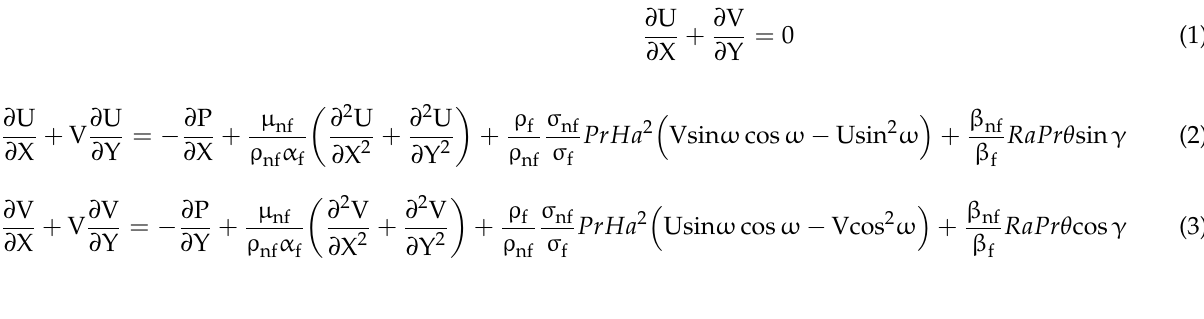
Figure 1. General schematic of the problem.